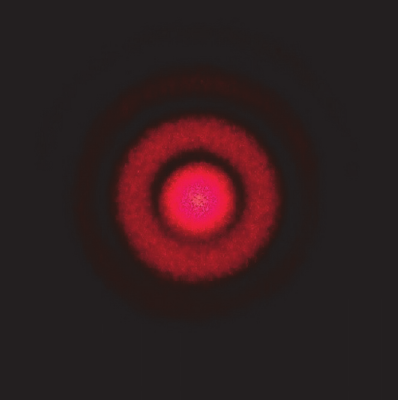
Fig. 2. Intensity distribution for a Bessel beam of order